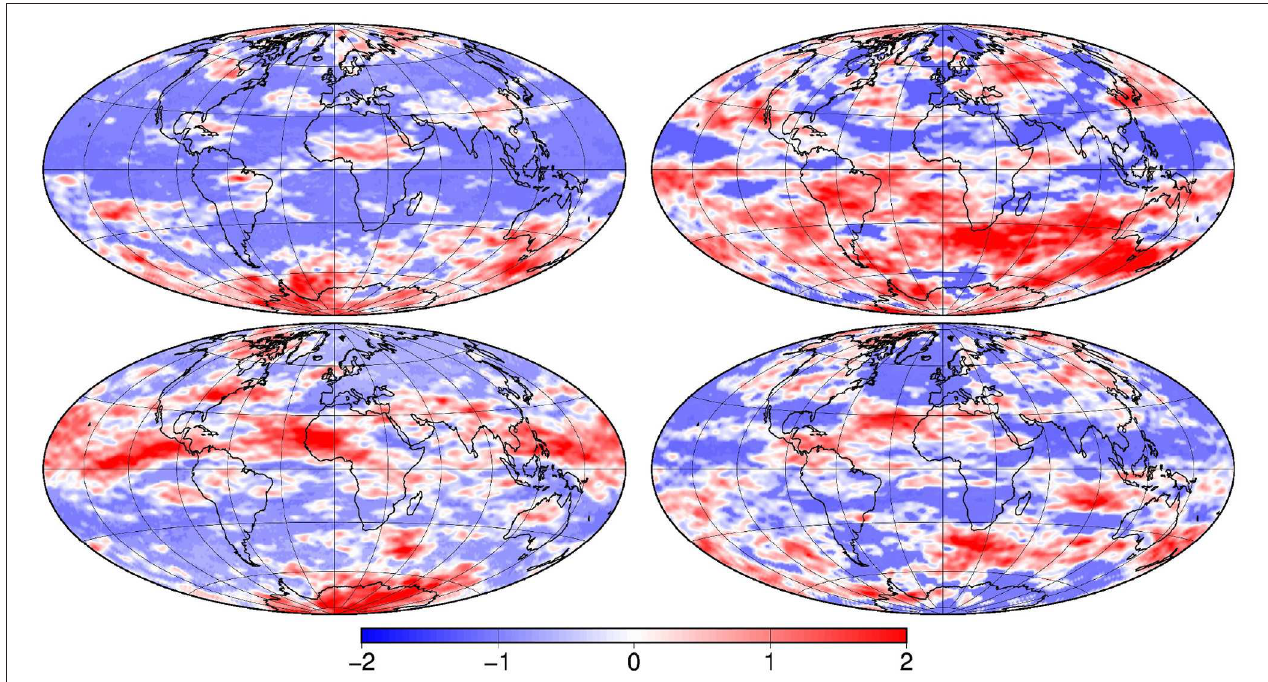
FIGURE 4 | Anamorphosis transformation of the 4 vectors x displayed in Figure 1